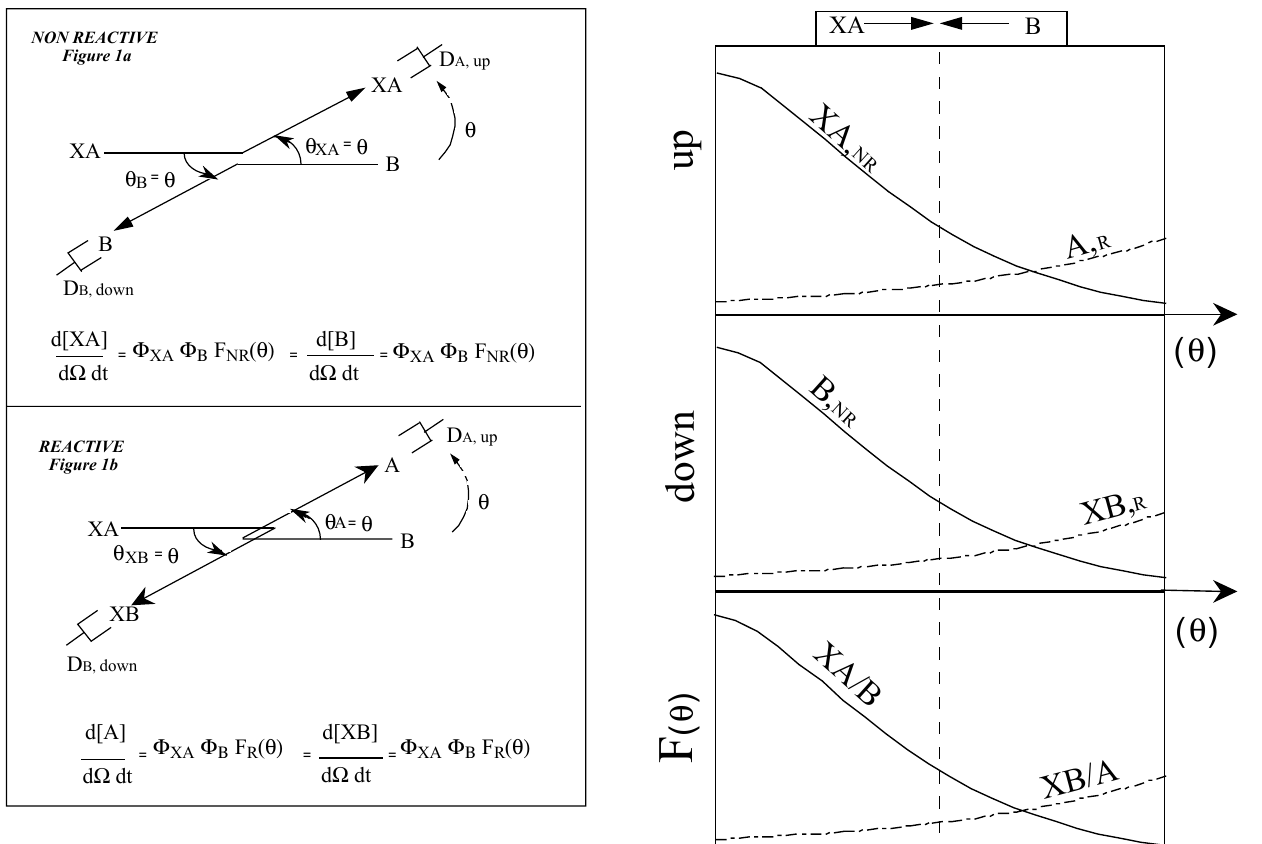
Fig. 1. Schematic diagram of the trajectory of different isotopic species as a function of their scattering angles in a cross beam ex- periment between XA and B. A and B are two isotopes of the same element. “Reactive” indicates that isotopes are exchanged in the course of the collision. A and XA are detected by D A and B and XB by D B . The differential scattering cross section measured by D A and D B are strictly equal at θ XA = θ B = θ .